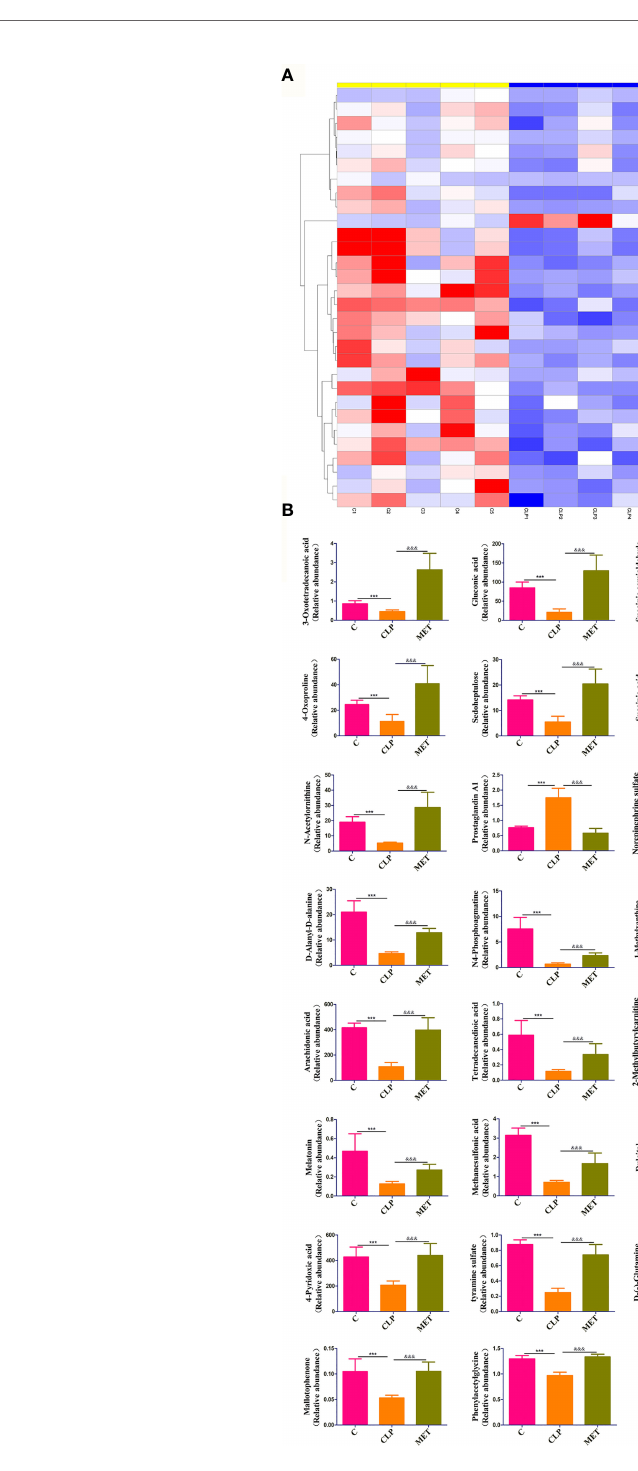
FIGURE 5 | Metformin affects the gut microbial metabolites in septic rats. (A) Untargeted metabolic analysis showed differences in the intensity of speci fi c metabolites among the groups. (B) 30 speci fi c metabolites showed signi fi cant differences among the groups. *: CLP vs C group; & MET vs CLP group. ***, &&& P<0.001 ( n =